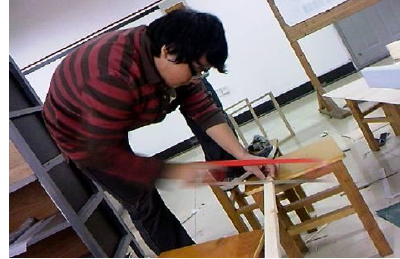
Fig. 1. Photo of space cognition teaching. Fig. 2. Photo of Comprehensive design teaching